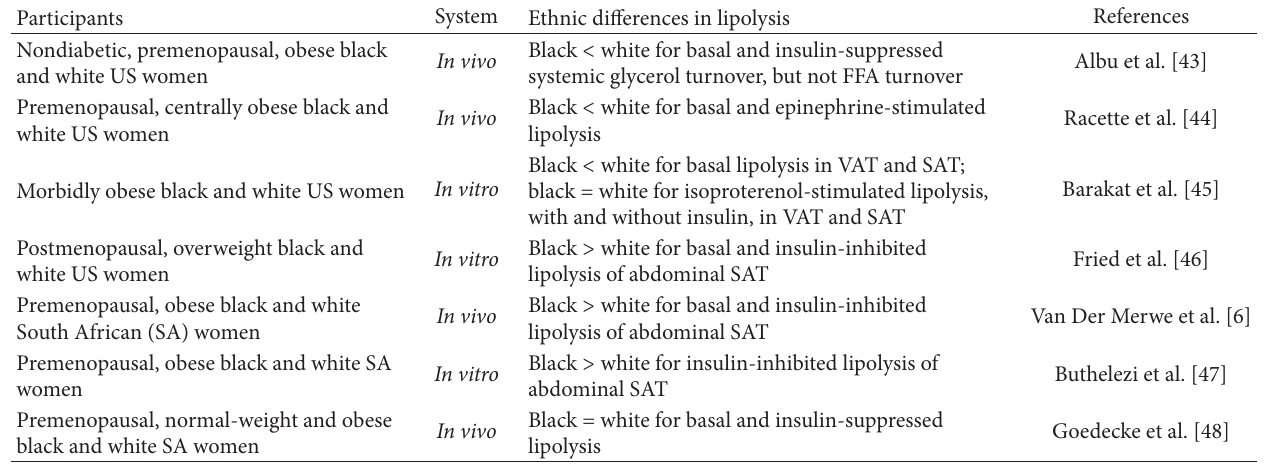
T 1: Ethnic differences in adipose tissue